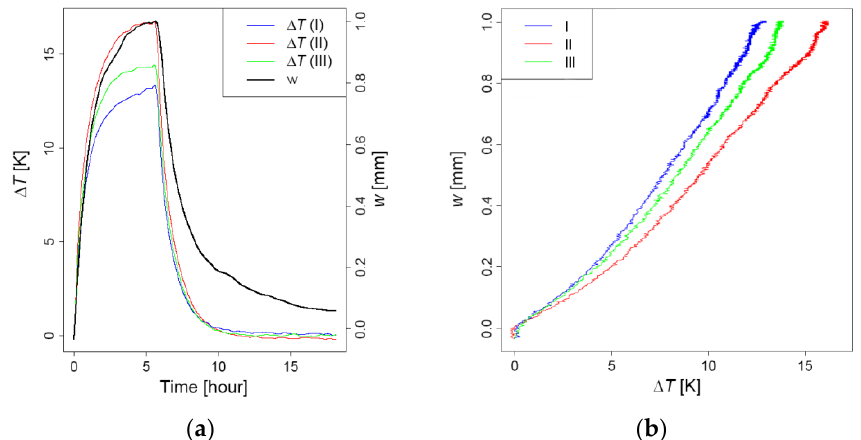
Figure 14. ( a ) The time response of the temperature difference and the top deflections; ( b ) The relation between the top deflections and the temperature difference.